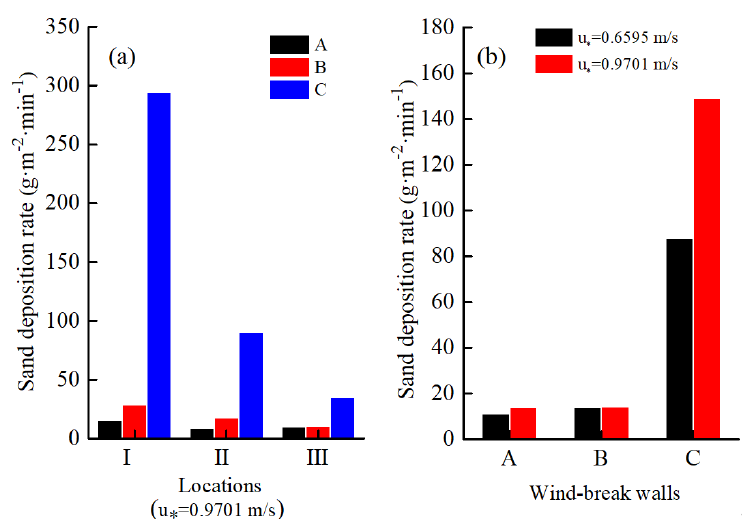
Figure 12. Sand particle deposition rates along three wind-break walls: ( a ) deposition rates at different locations and ( b ) total deposition rates at different wind